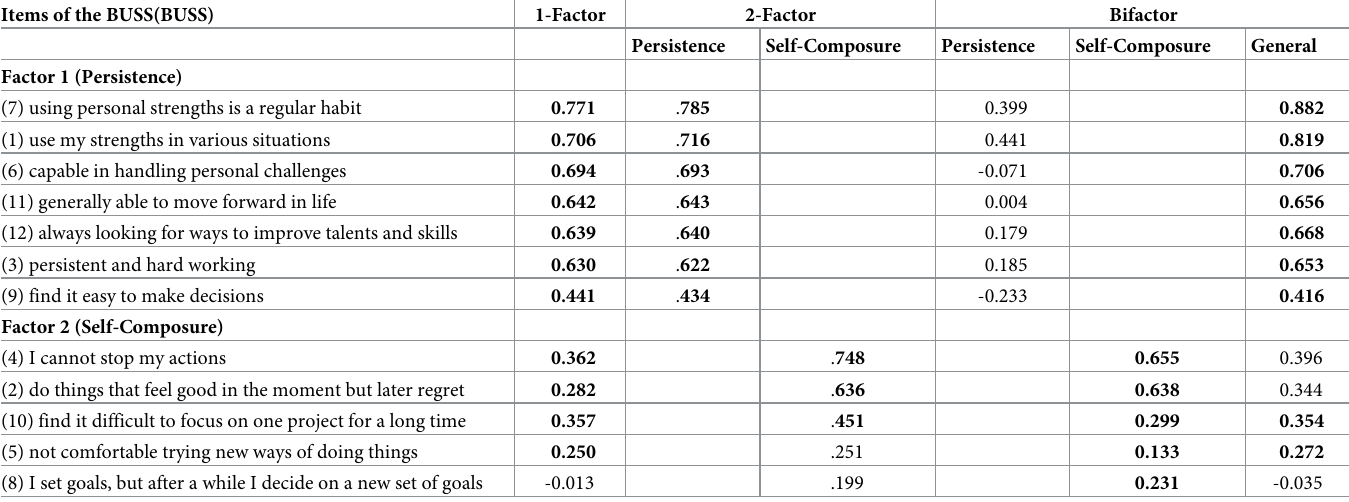
Table 3. Maximum likelihood estimates of factor loadings for the BUSS for 1-factor, 2-factor and bifactor CFA. Items of the